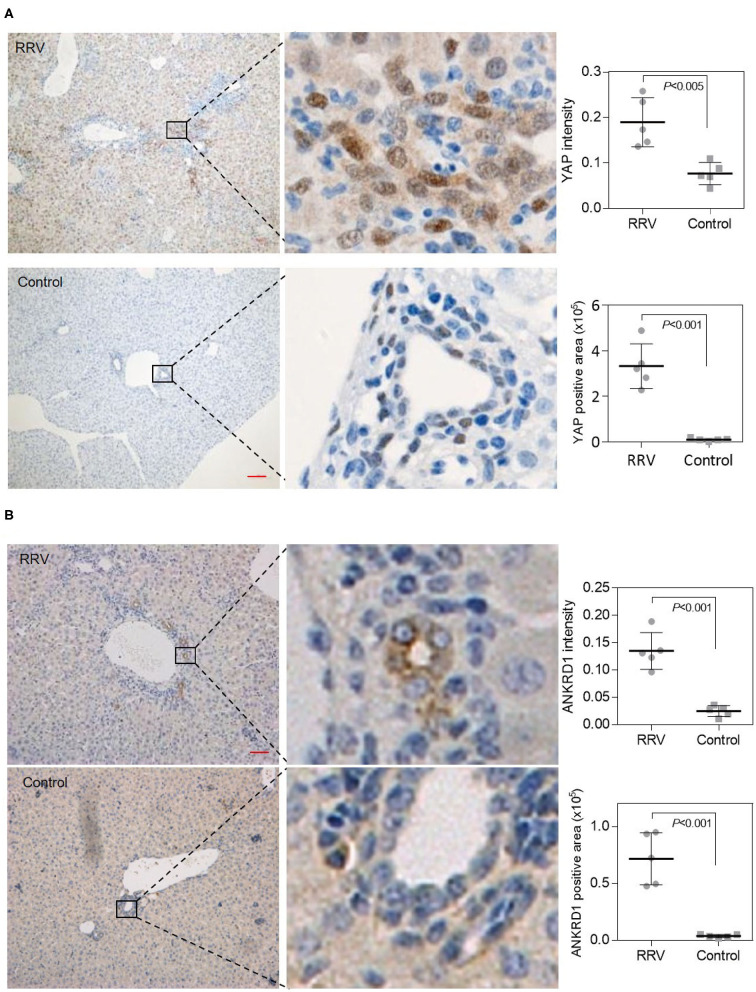
Increased YAP and ANKRD1 expression in an RRV-induced murine BA model. (A) Elevated YAP expression in RRV-induced BA mouse livers as assessed by IHC (left) and quantified (right). Scale bar: 100 μm. Both YAP positive area and IHC signal were increased in BA mouse livers (right) (n = 5). (B) Elevated ANKRD1 expression in RRV-induced BA mouse livers as assessed by IHC (left) and quantified (right). Scale bar: 100 μm. Both ANKRD1 positive area and IHC signal were increased in BA mouse livers (right) (n = 5).